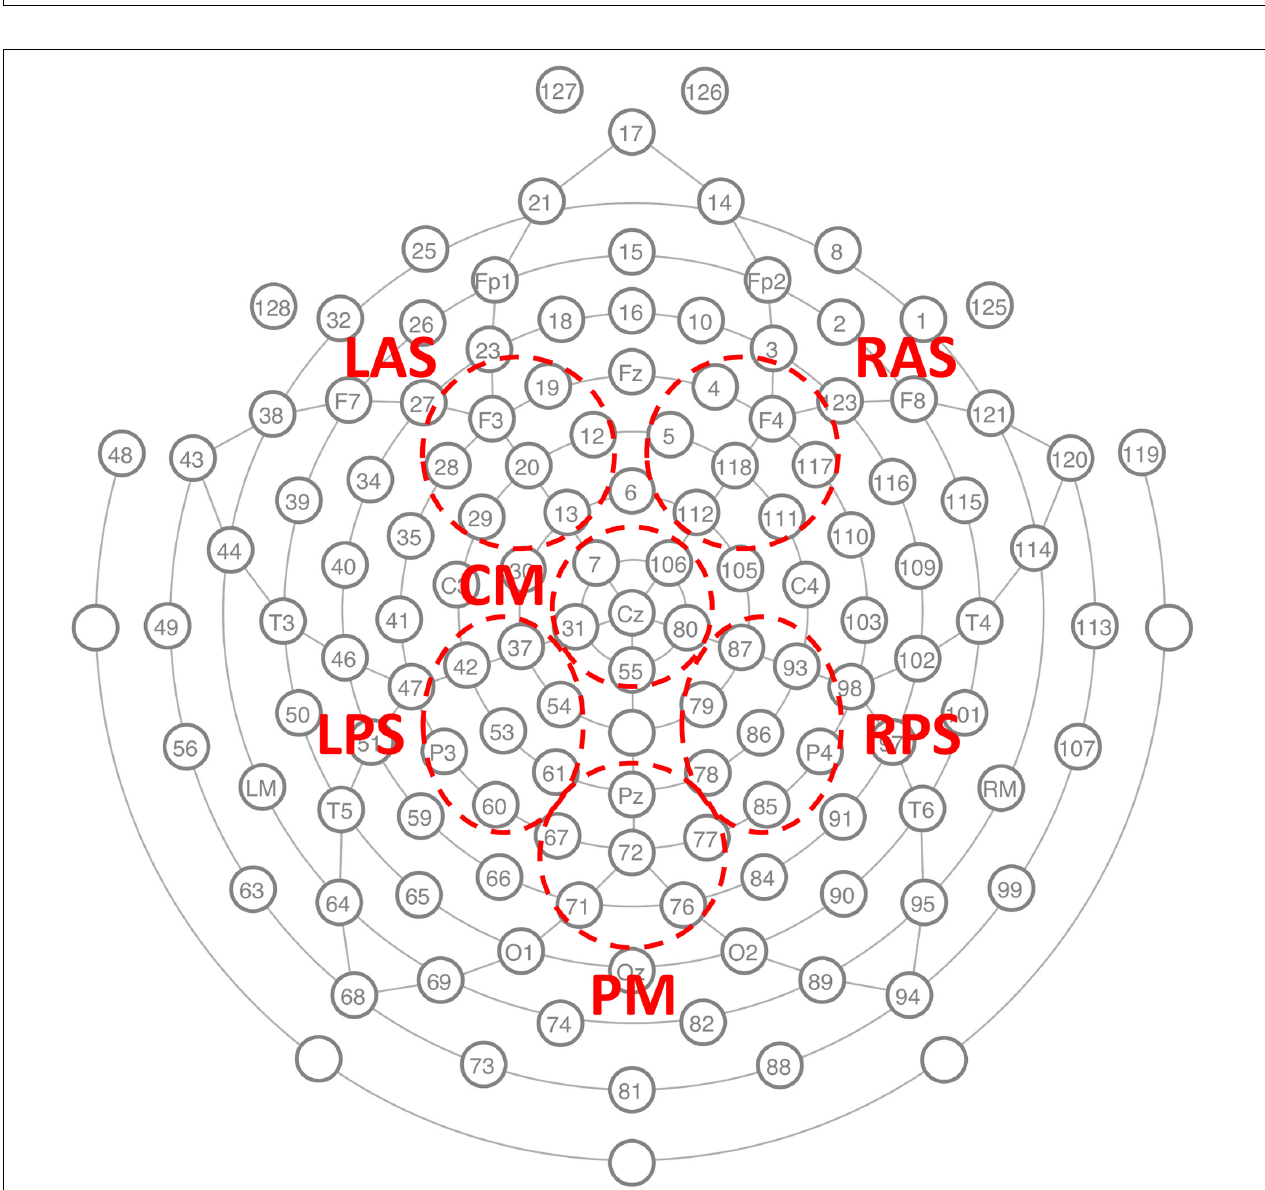
FIGURE 2 | The GSN electrode locations used to record the EEG and the six channel groups on which classification analysis was conducted. LAS left anterior superior , RAS right anterior superior, CM central medial , LPS left posterior superior , RPS right posterior superior, and PM posterior medial .